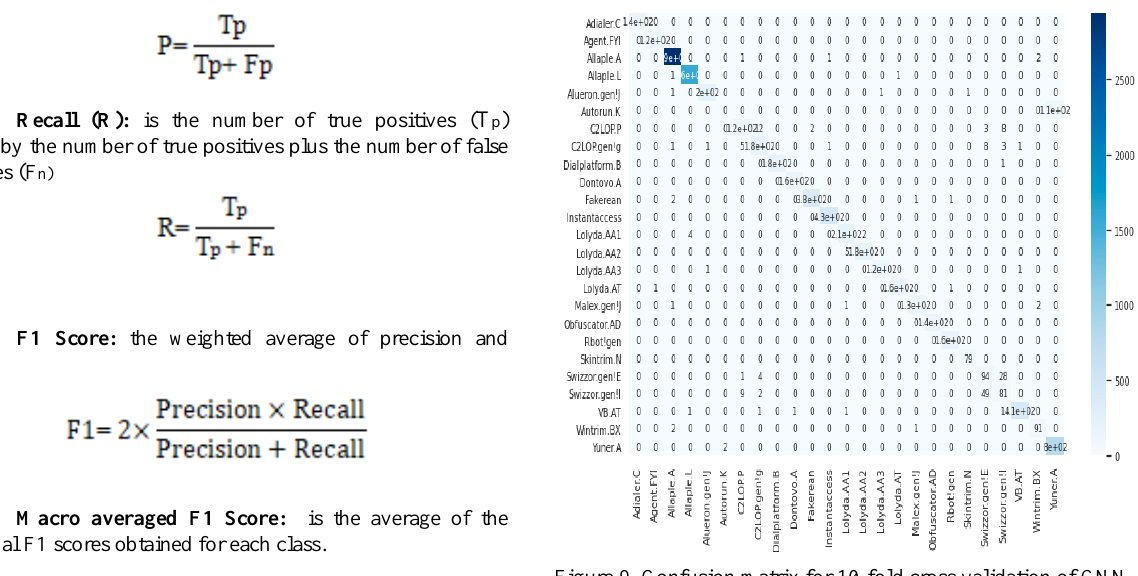
Figure 9. Confusion matrix for 10-fold cross validation of CNN model with 3 convolutional layers connected to one fully connected layer.